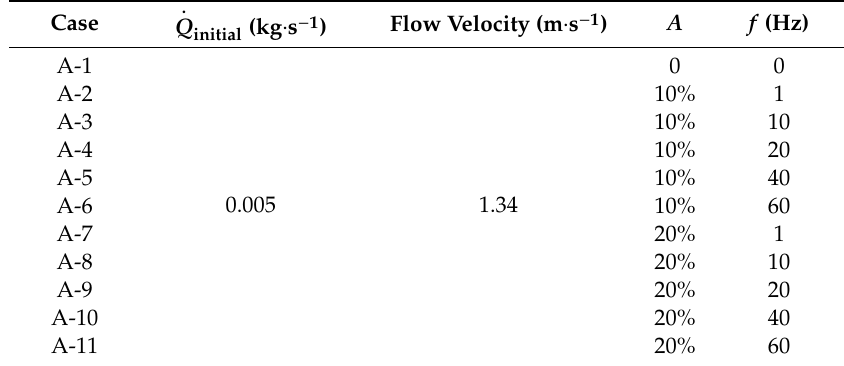
Table 2. Computational